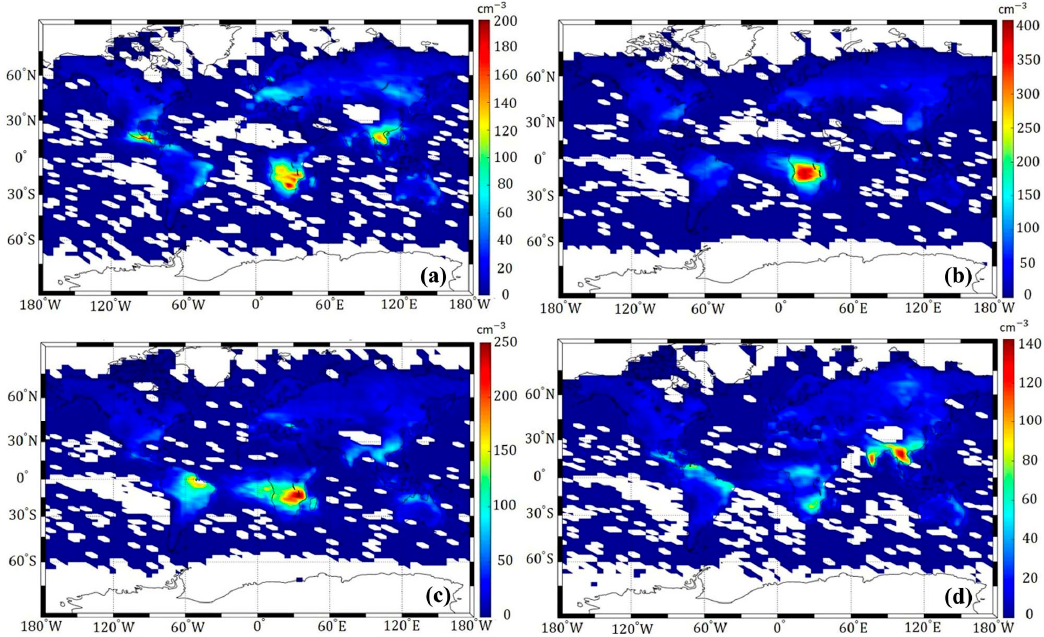
Figure 5. Spatial distributions of seasonal smoke aerosol MFNC averaged from 2006 to 2016. ( a ) Spring; ( b ) summer; ( c ) autumn; ( d ) winter. White area indicates no data. It should be noted that the scale of color bars is different from each other. Remote Sens. 2020 , 12 , x FOR PEER REVIEW